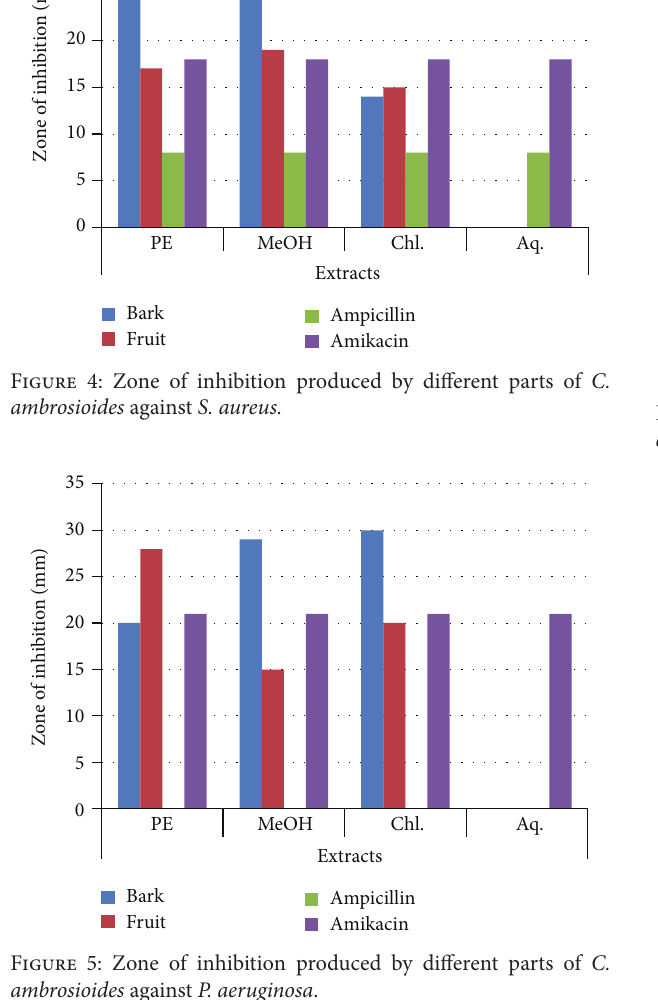
Figure 7: Zone of inhibition produced by different parts of C. ambrosioides against A. oryzae .